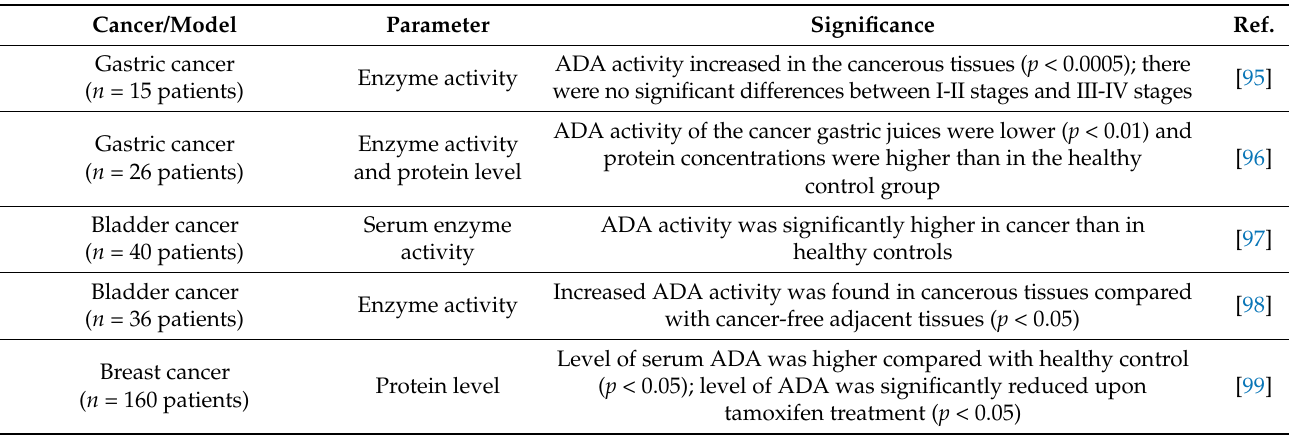
Table 3. The role of ADA in